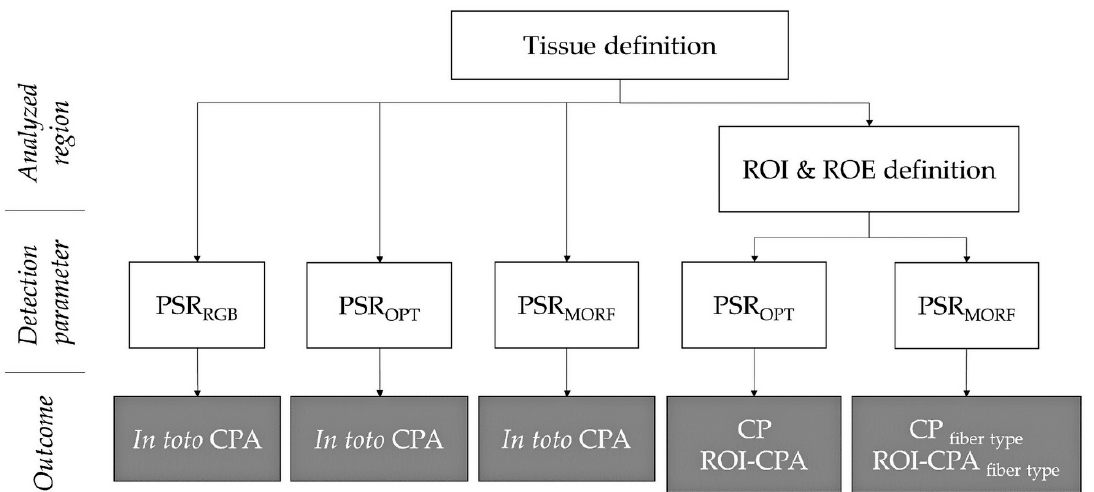
Figure 2. Analysis workflow for in toto vs. regionalized quantification using the three developed detection algorithms: RGB method (PSR RGB ), optimized method (PSR OPT ) or morphological fiber classification (PSR MORF ). ROI, region-of-interest; ROE, region-of-exclusion; CPA, collagen proportionate area; CP, collagen proportion.